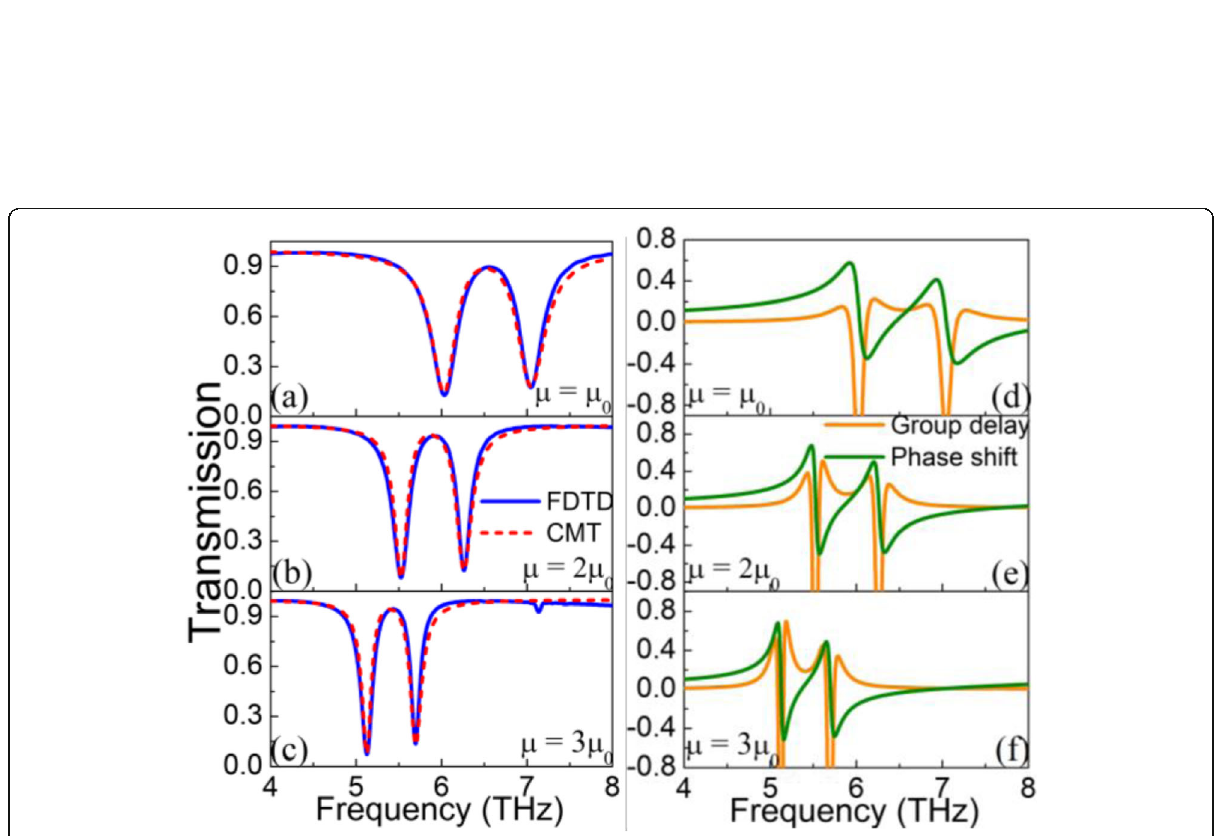
Fig. 5 a – c Transmission spectra of FDTD simulation and CMT fitting with different graphene mobility μ = μ 0 , 2 μ 0 , 3 μ 0 . d, e Transmission phase shift and the group delay with different graphene mobility μ = μ 0 , 2 μ 0 , 3 μ 0 . Here, E f 1 = E f 2 = 1.2